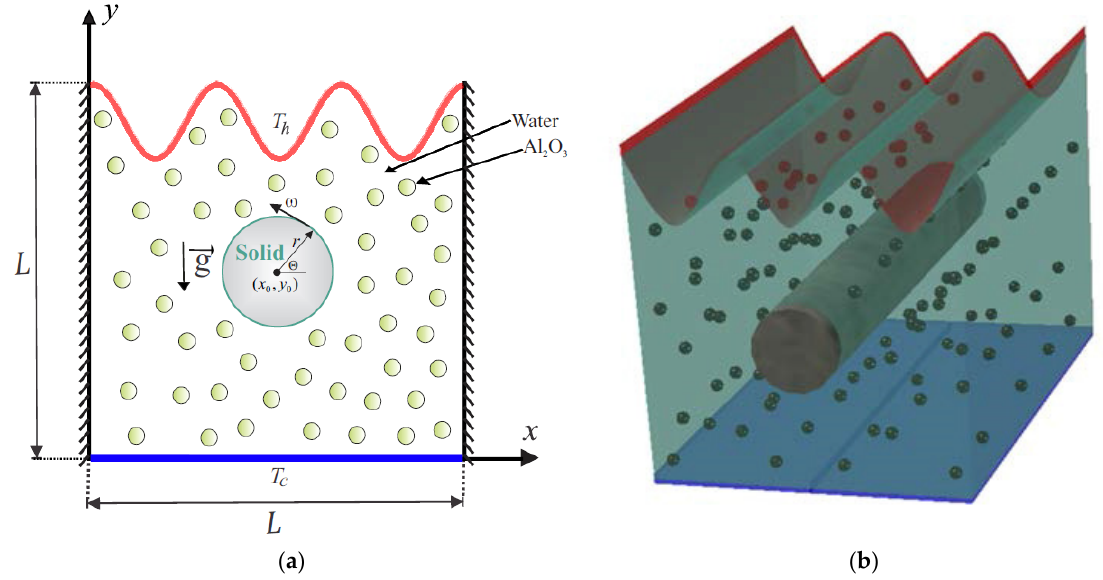
Figure 1. ( a ) 2D schematic representation in the plane ( X and Y axes); ( b ) 3D schematic representation of the physical design.